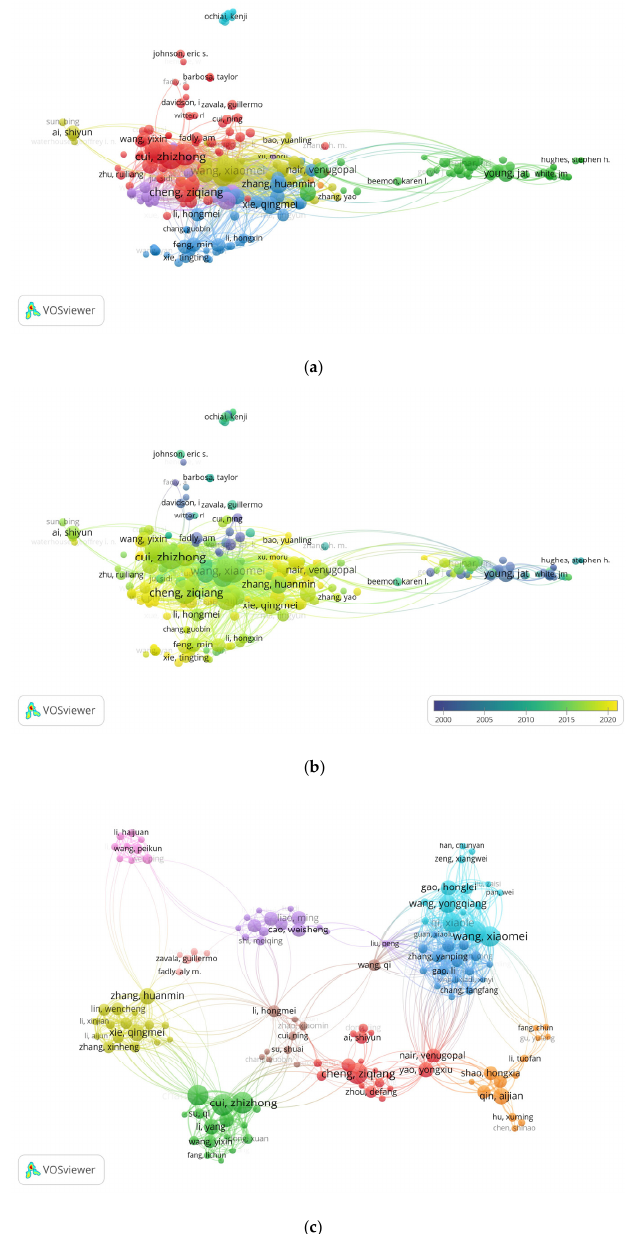
Figure 3. The authorship analysis of authors/researchers/scientists. Each node represents an author, the node’s size shows the author’s count of publications, and each line/edge connecting two authors/researchers indicates the betweenness among researchers. ( a ) The network-visualization map of most cited researchers/authors in the ALV literature. ( b ) Overlay visualization map of the most cited researcher/authors in the ALV research. ( c ) Co-authorship collaboration among researchers. Every node symbolizes a researcher, and the line’s thickness denotes the frequency of co-authorship collaboration amongst the